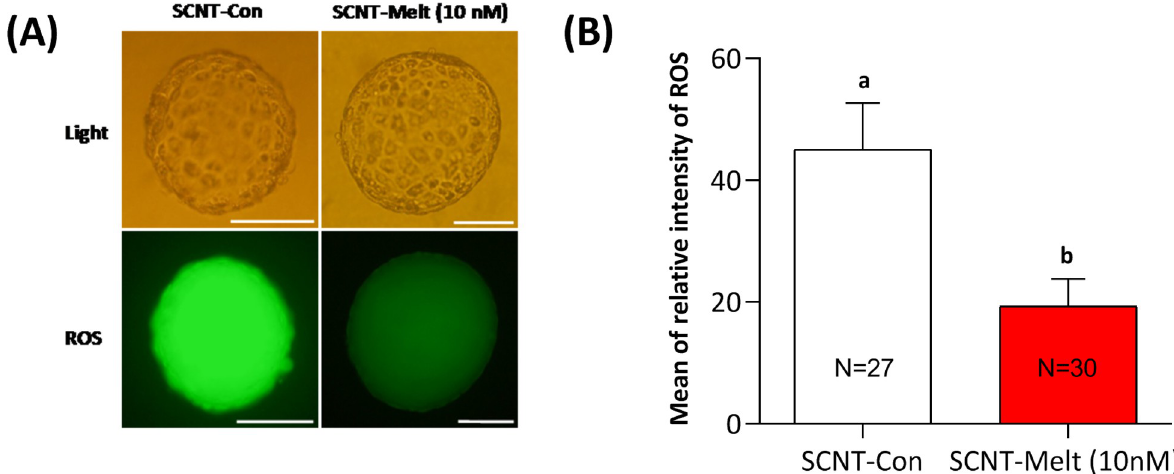
Fig 2. Effect of melatonin on ROS levels in ovine SCNT embryos at blastocyst stage. A) Representative images from H2DCFDA staining of blastocysts derived from SCNT-Con and SCNT-Melt (10 nM) groups. Scale bar, 100 μ m. B) The mean of relative fluorescent intensity of ROS in ovine SCNT blastocyst. The data were shown as mean ± SEM. Values with different letters have a statistically significant difference ( P < 0.05).